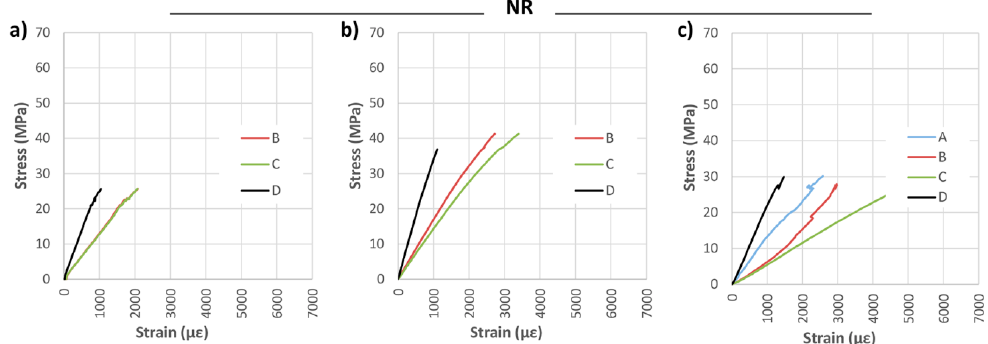
Figure 7. Stress against strain during bending tests: ( a ) NR-1; ( b ) NR-2; and ( c ) NR-3.